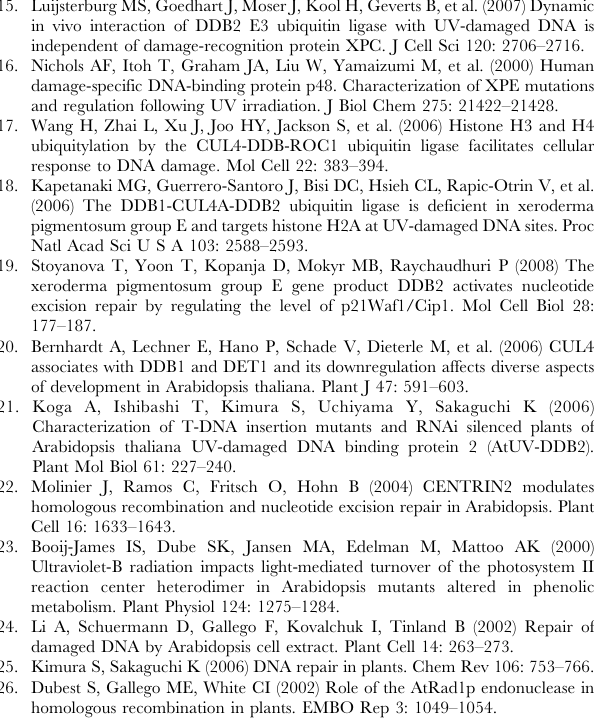
after. Relative weight was calculated relative to the corresponding untreated plants ( 6 SEM). Eight plants per replicate were used and experiments were triplicated. For all mutants no significant difference was found compared to WT plants.